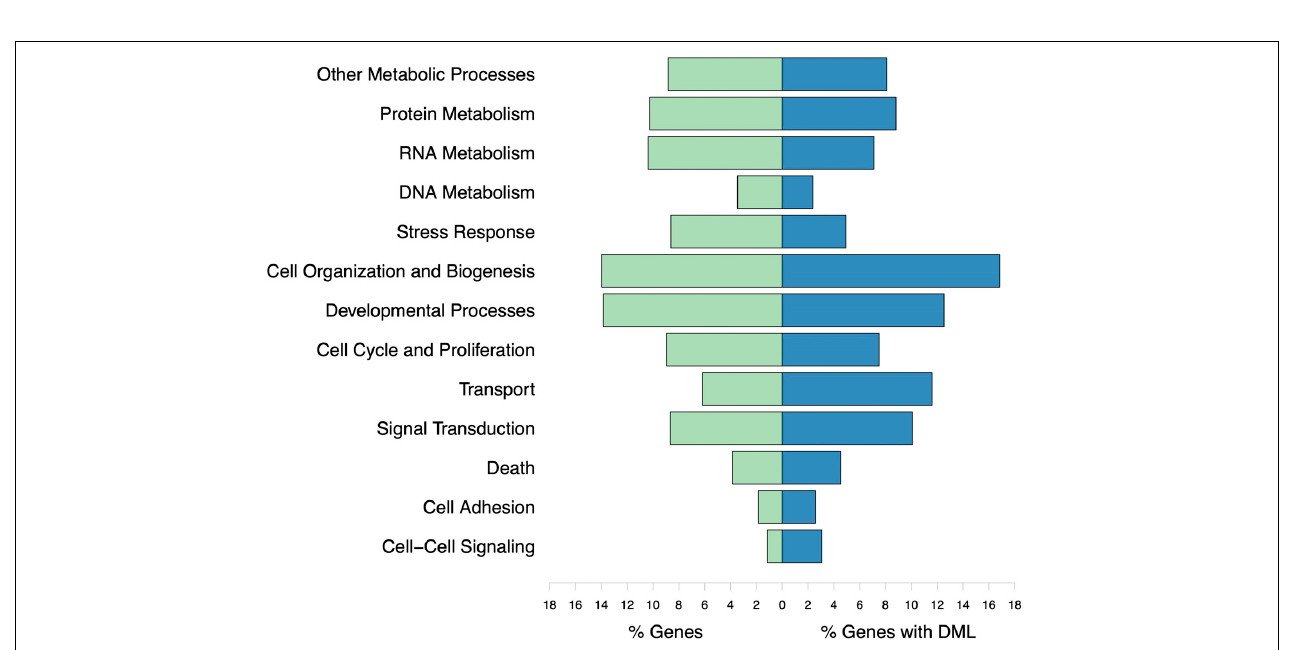
FIGURE 7 | Distribution of hyper- and hypomethylated DML along a hypothetical gene. The scaled position of a DML within a gene was calculated by dividing the base pair position of the DML by gene length. Counts of hypermethylated DML are plotted above the x -axis, and hypomethylated DML counts are below the x -axis.